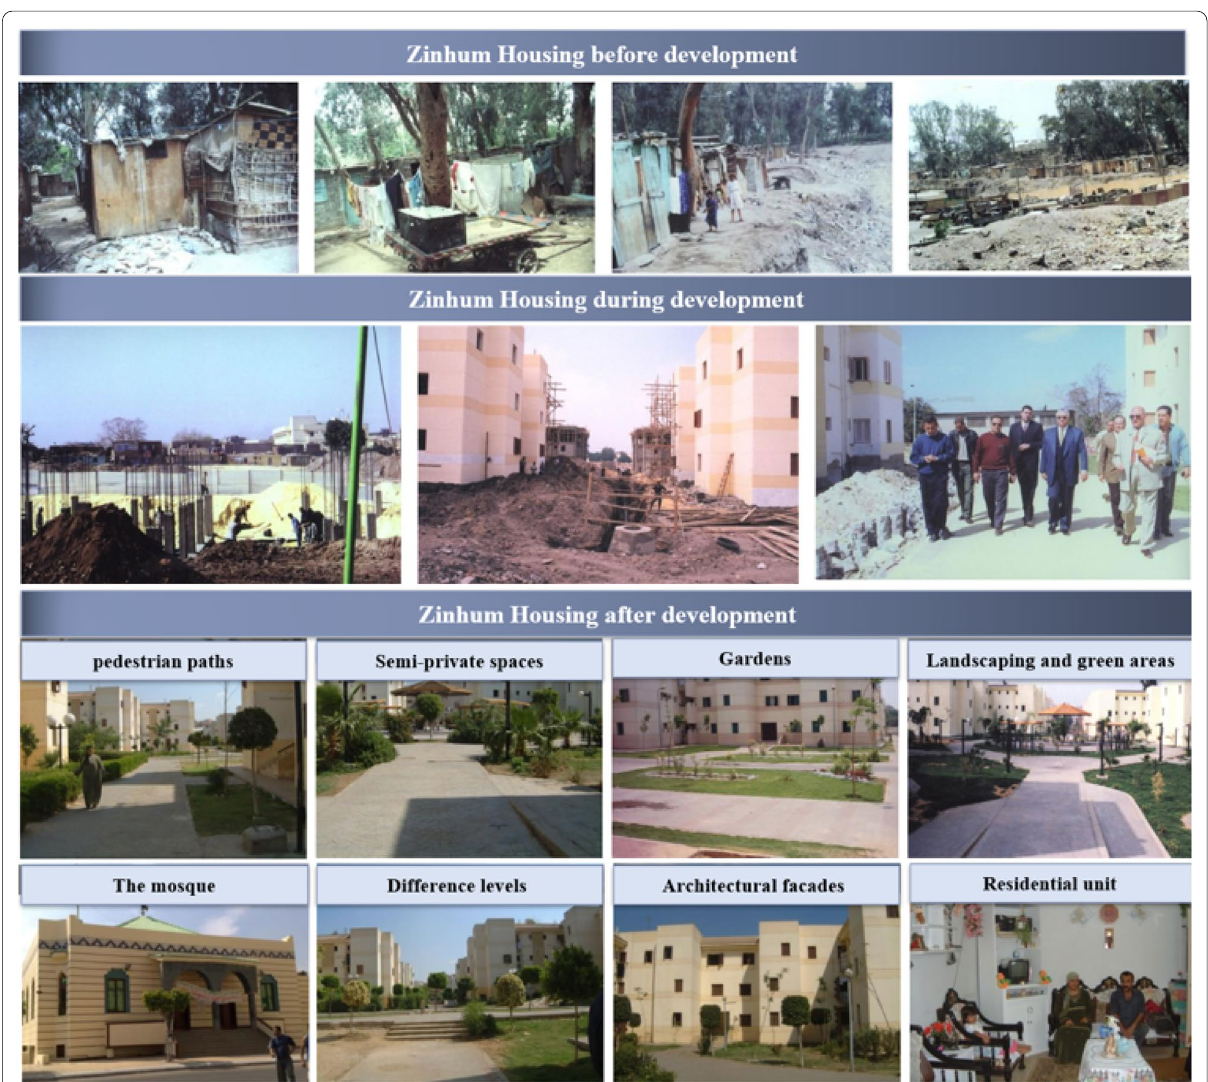
Fig. 10 Zinhum Residence before, during and after development. ( Source: Adapted researcher “Tools and Methods of Dealing with Degraded Areas and Slums”, Training Course in Urban Planning and Local Economy Development, United Nations Human Settlements Program,